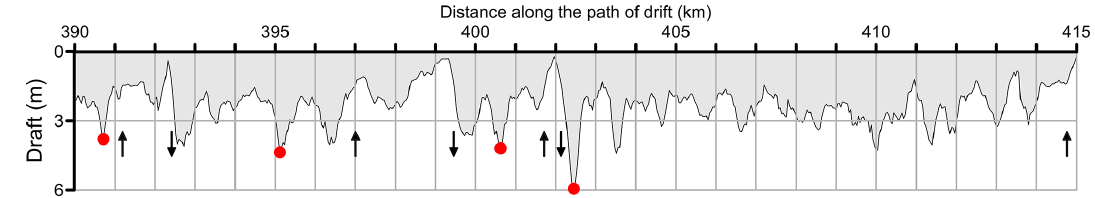
Figure 16. A 25km segment of the section measured by sonar, The curve displays 250m averaged values of ice draft. The red dots mark keels identified using the Rayleigh criterion. The down and up arrows mark the arriving and departing edges of floes, respectively.